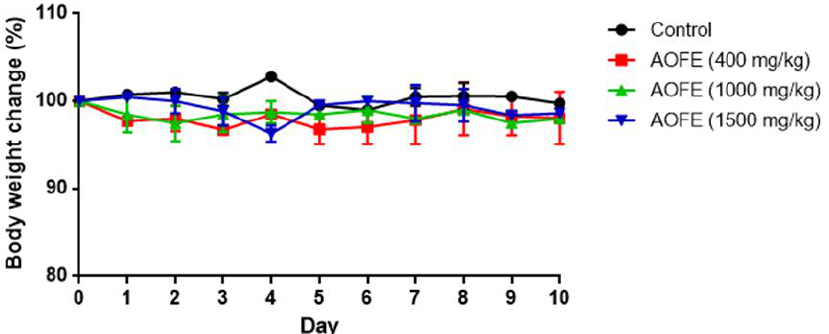
Figure 5. Effect of AOFE administration on mouse body weight. BALB/c mice were administered p.o. with 100 μL of 50% ethanol (control) or AOFE (400, 1000, or 1500 mg/kg bw in 50% ethanol) daily for 10 days. Mouse body weight was measured daily and compared with the weight on day 0 ( n = 3).